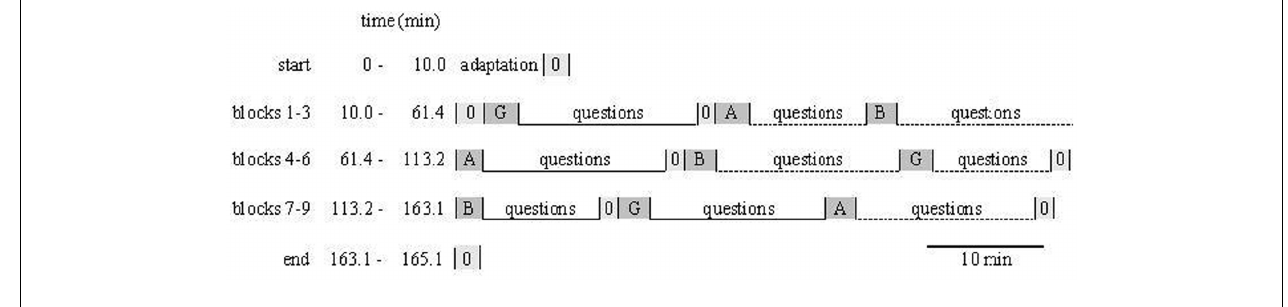
randomized order. After each language task (acoustic presentation), recording was interrupted for questions to explore factual listening comprehension, the attitude toward the speaker, interest for the contents, attention, work-load, and subjective comprehension (0 = baseline